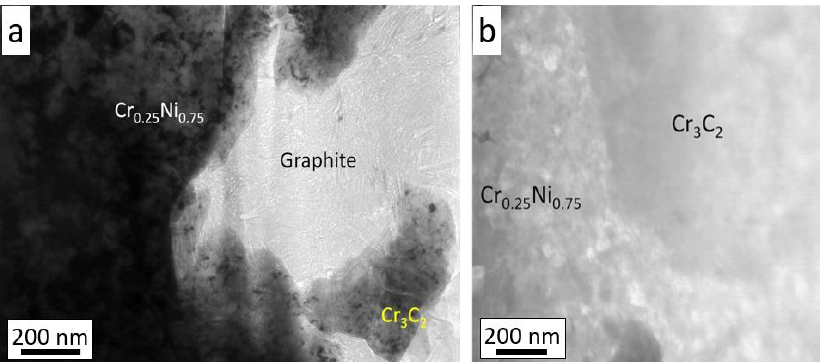
Figure 8. Cross-section and map of elements distribution (Cr, Ni, C) of coating deposited with parameters set 1 (TEM).